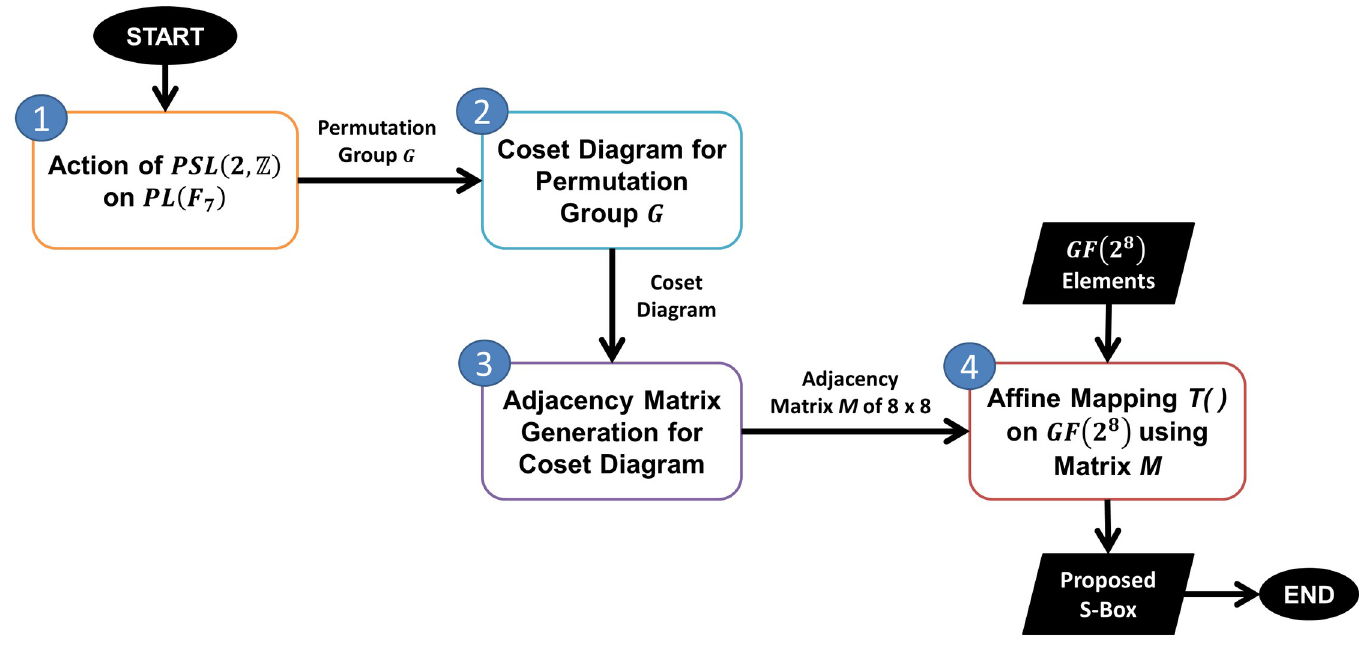
Fig 1. Proposed methodology for S-box